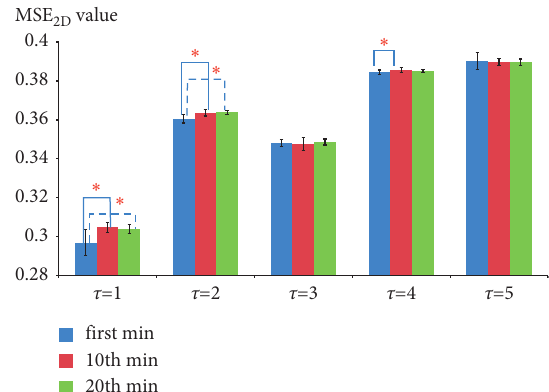
Figure 2: MSE 2D values of plantar pressure images from the time scales τ � 1 to 5 at the 1 st min, 10 th min, and 20 th min during 1.8 mph speed. ∗ indicates p < 0 . 05.